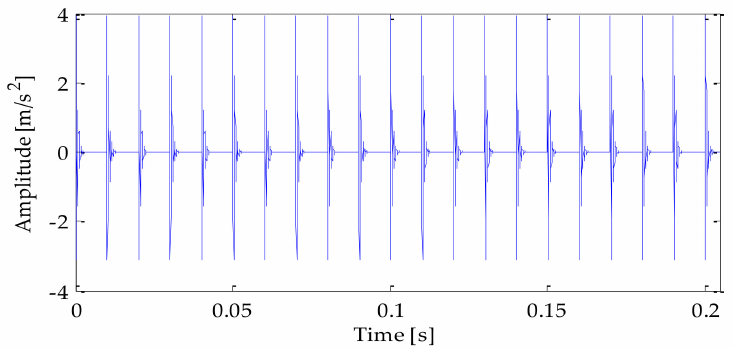
Figure 4. Time–domain waveform of the simulated signal.